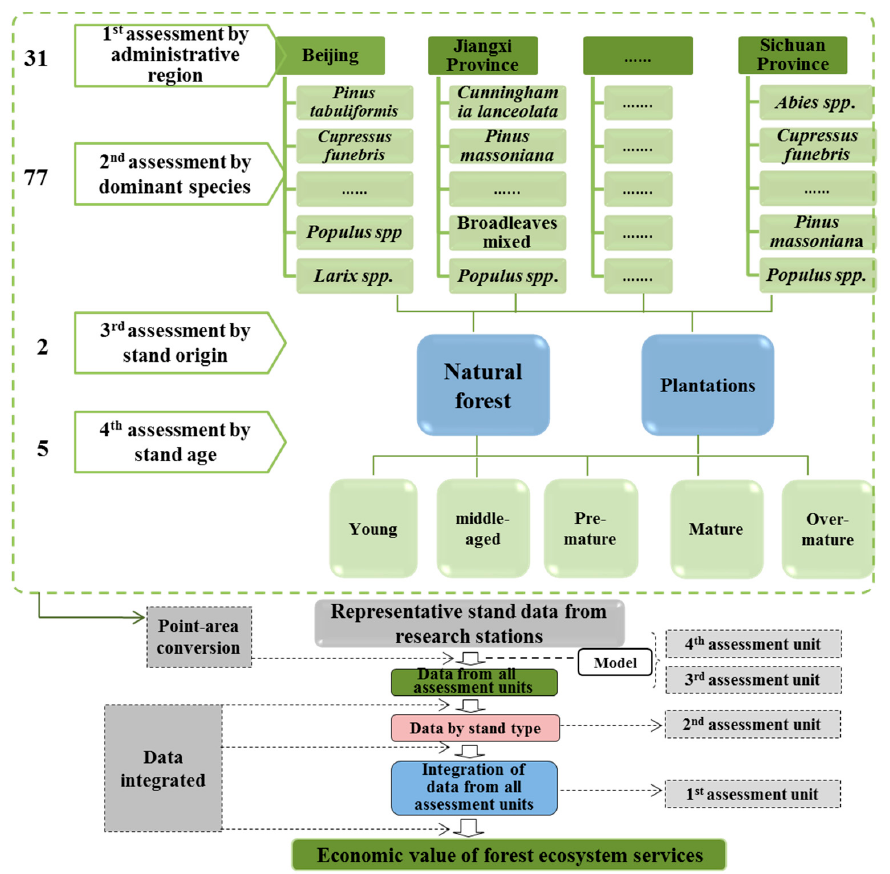
Figure 4. Description of how the Distributed Valuations (DVs) for forest ecosystems services in China are determined using various data sources. Note: “…” in the Figure denotes the other provinces and tree species in China.